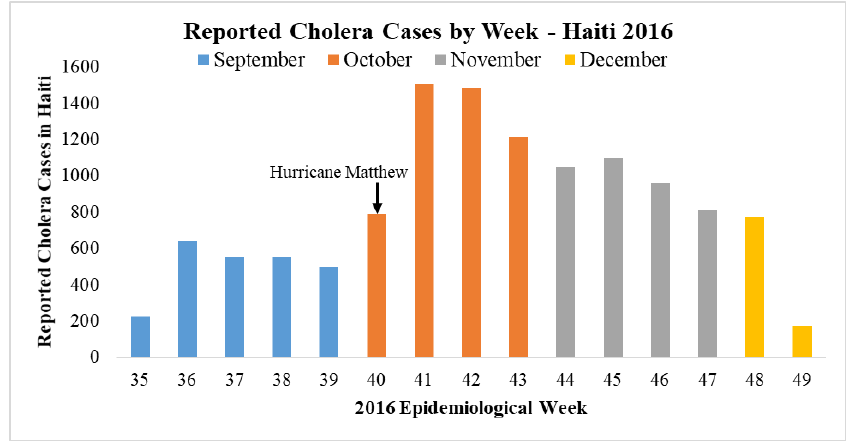
Figure 4. Reported cholera cases from 10 departments by week in Haiti before and after Hurricane